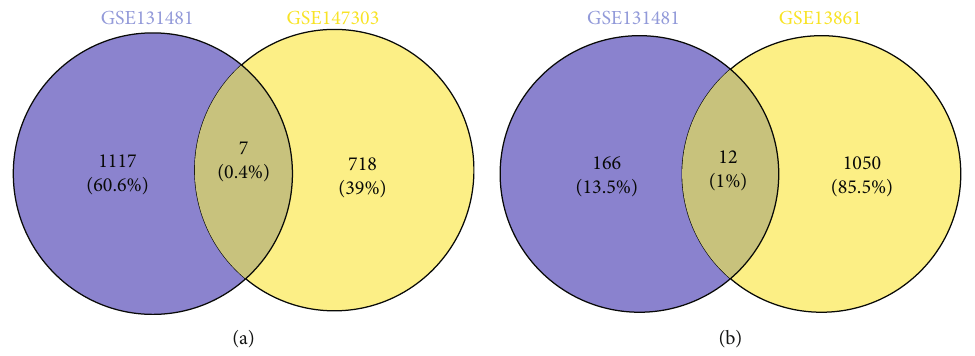
Figure 2: (a) The intersection of DEcircRNAs. (b) The intersection of DEGs. Table 1: The host gene symbol of